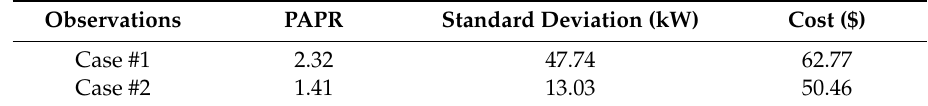
Table 4. Summary of case #1 and #2.